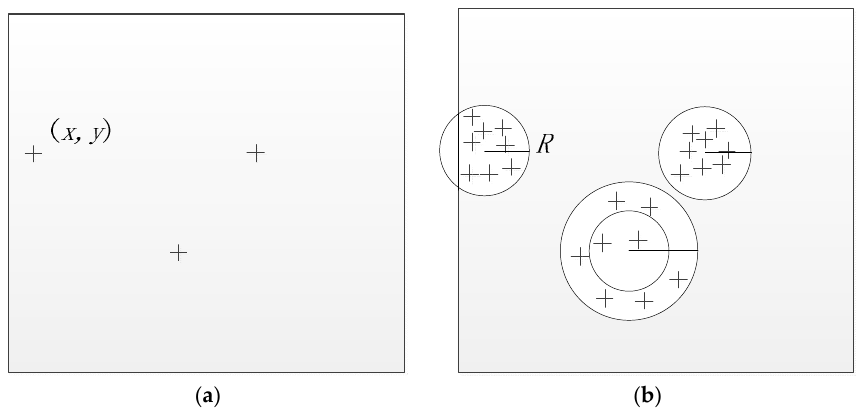
Figure 4. Geometric SIFT matching method which just searches the key points in the predict area. ( a ) The left image with the key point ( x r , y r ) ; ( b ) The right image with the circle of radius R in ( x s , y s )